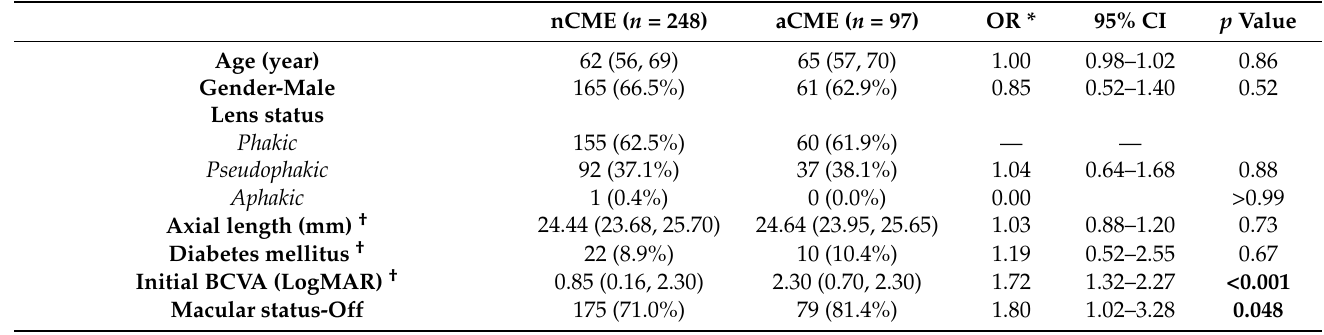
Table 2. Risk factors for cystoid macular edema at 12 months univariate